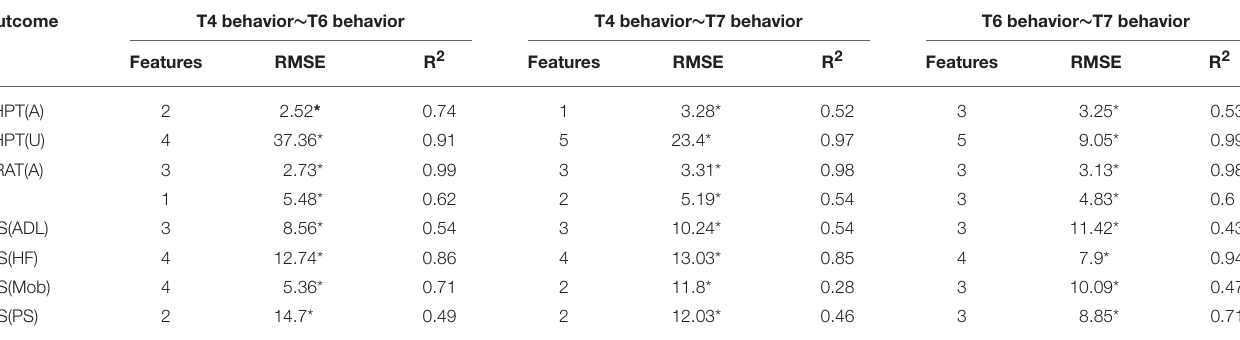
TABLE 8 | Linear-kernel SVR performances based on leave-one out cross-validation to correlate behavioral measures at preceding time-point and clinical variables with behavioral measures at succeeding time-point are presented. Outcome T4 behavior ∼ T6 behavior T4 behavior ∼ T7